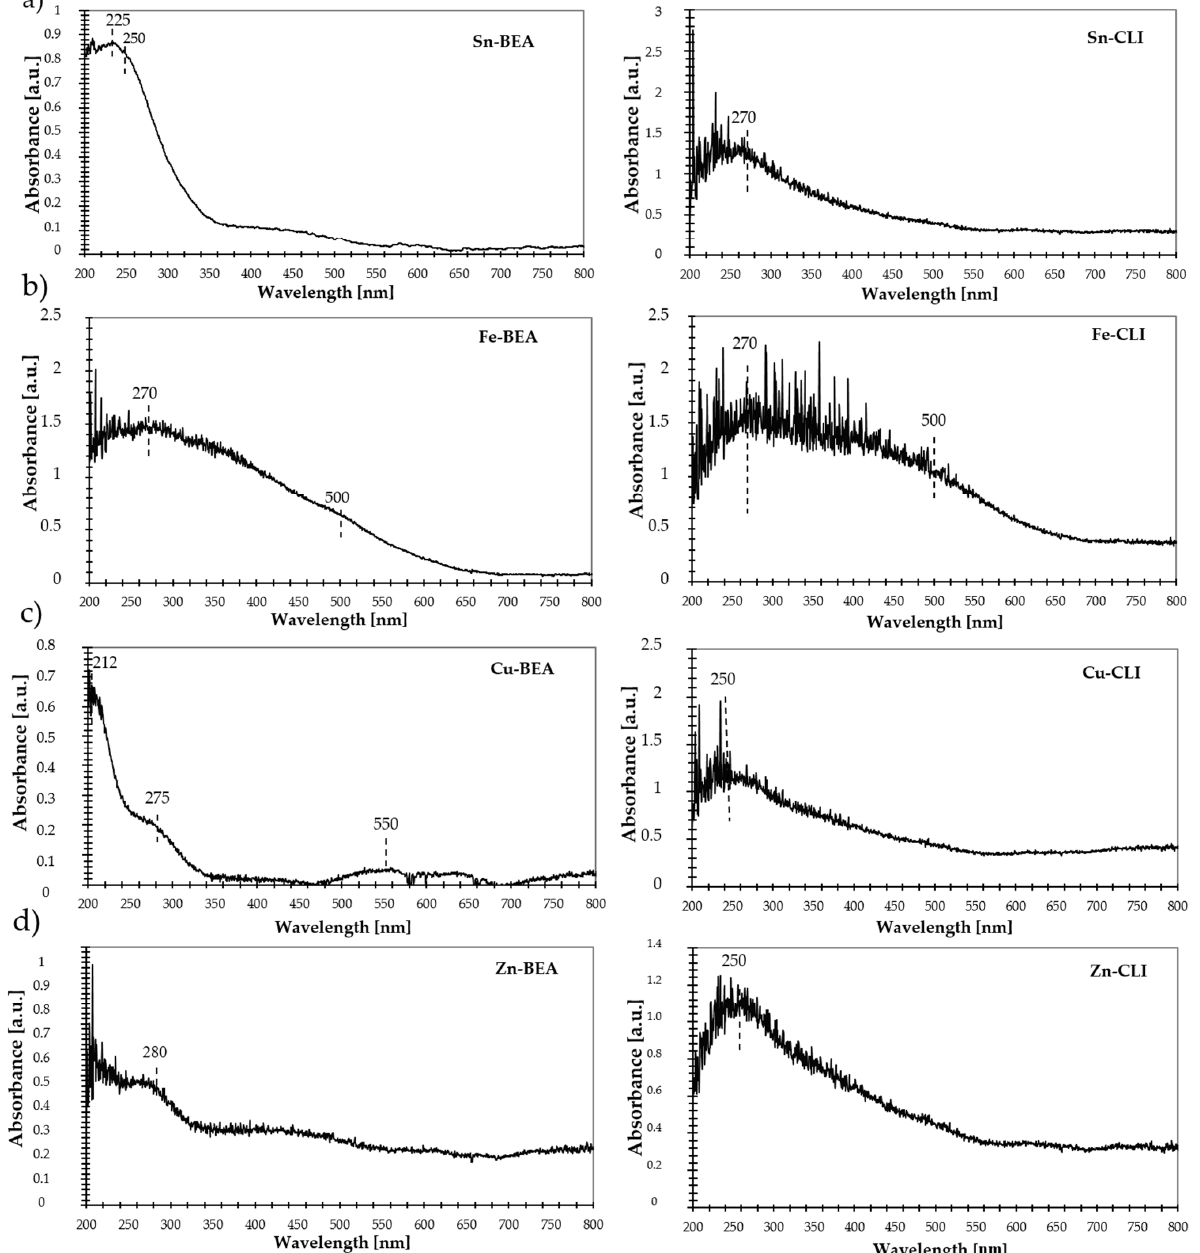
Figure 8. DR UV ‐ VIS spectra for BEA (left column) and CLI (right column): ( a ) Sn, ( b ) Fe, ( c ) Cu and ( d ) Zn.